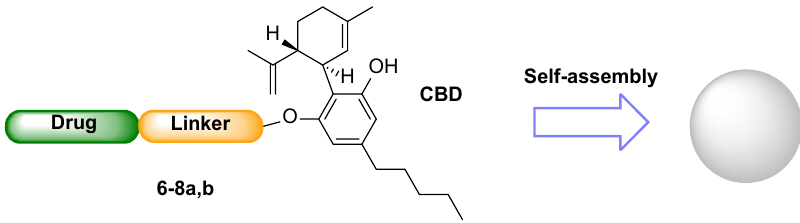
Figure 2. Self-assembly of NPs 6–8A,B from CBD-linker-drug conjugates 6–8a,b .